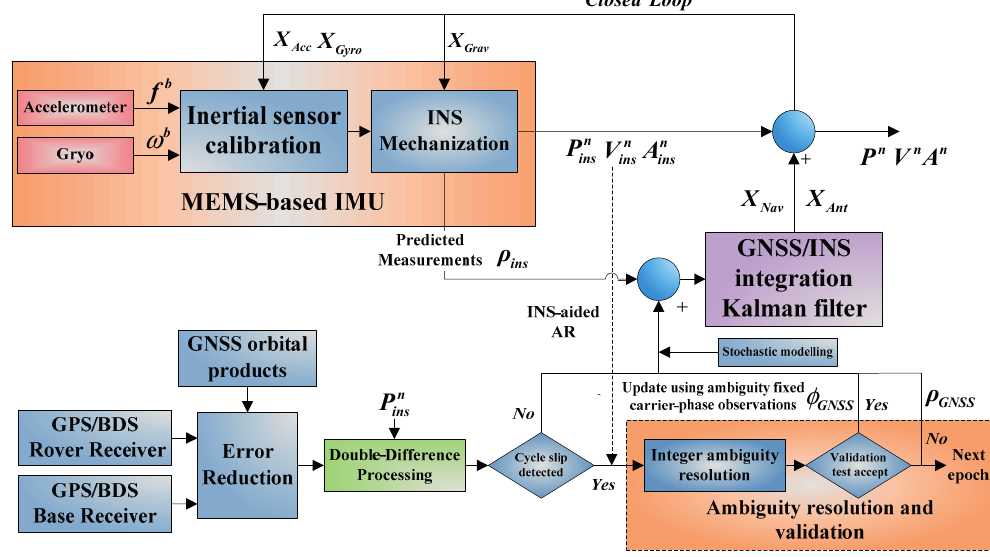
Figure 1. Implementation of the carrier phased-based tightly coupled GPS/BDS/INS